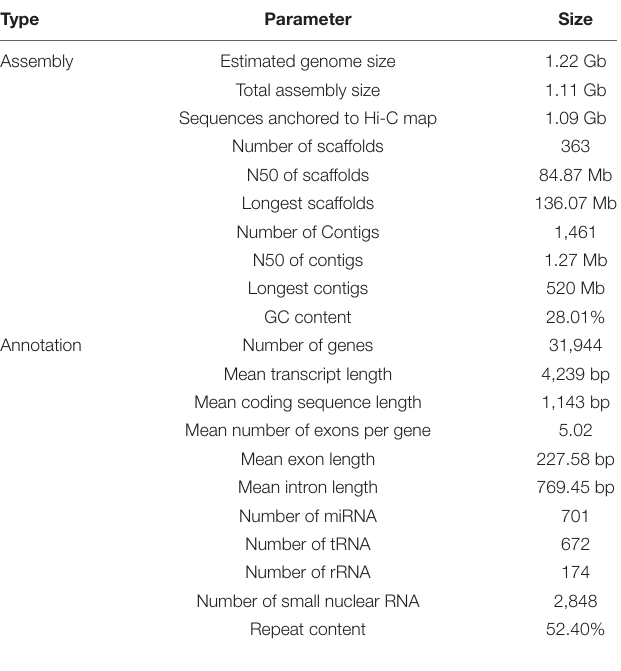
TABLE 1 | Statistics of genome assembly and